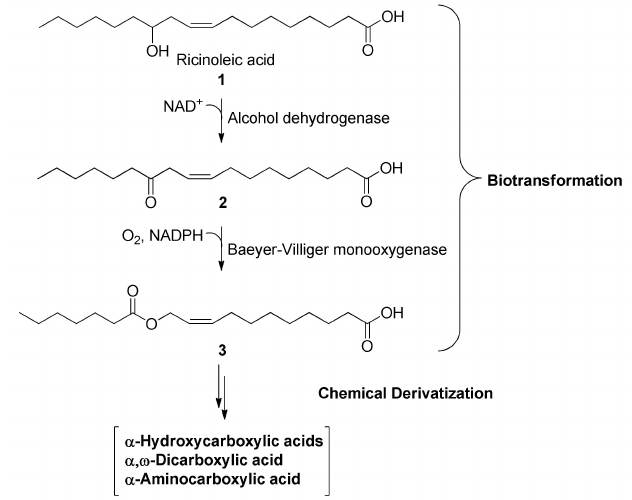
Figure 1. Designed biotransformation pathway of converting ricinoleic acid in Escherichia coli cells to ester intermediate ( 3 ) and its chemical